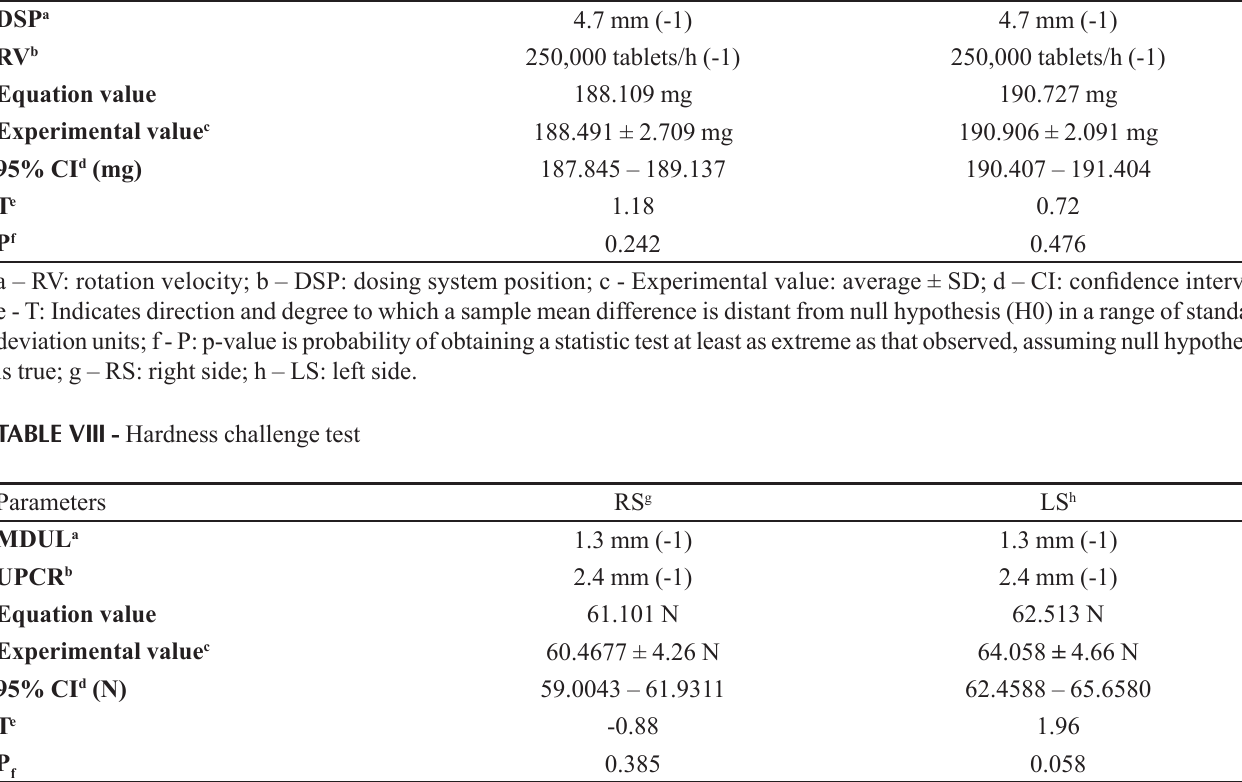
TABLE VII - Mean weight challenge test Parameters